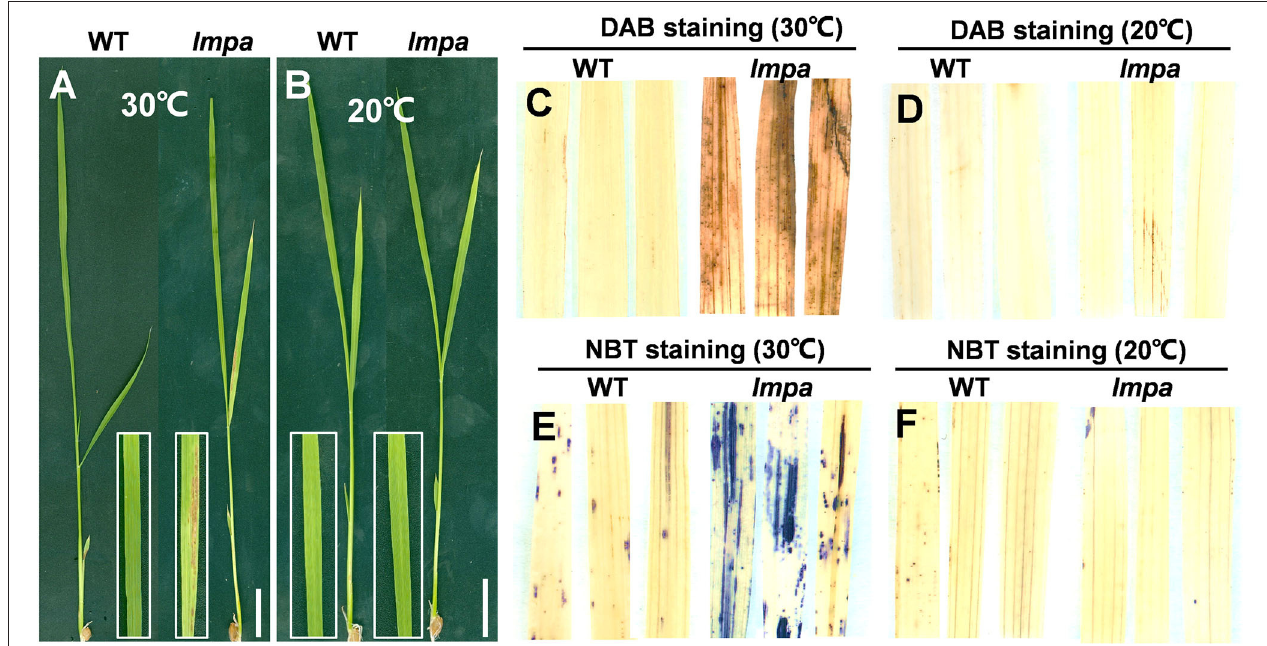
FIGURE 8 | Temperature treatment, and DAB and NBT staining. (A,B) Phenotypes of WT and lmpa mutant under different temperatures. (C,D) DAB staining of leaves grown at 30 ◦ C (C) and 20 ◦ C (D) . (E,F) NBT staining of leaves grown at 30 ◦ C (E) and 20 ◦ C (F) . Bars = 2cm in (A,B) .